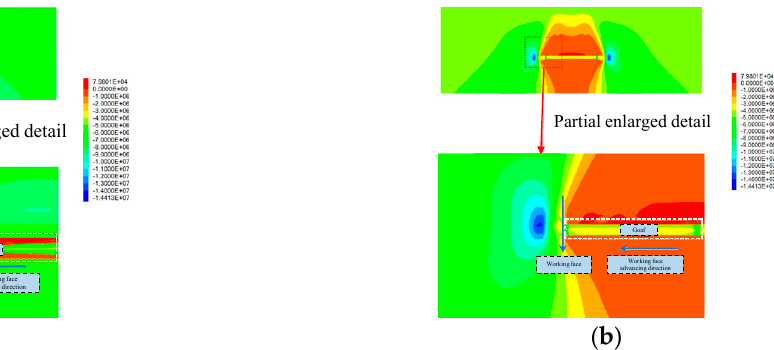
Figure 9. Local stress nephogram after grouting. ( a ) End section; ( b ) Middle section.